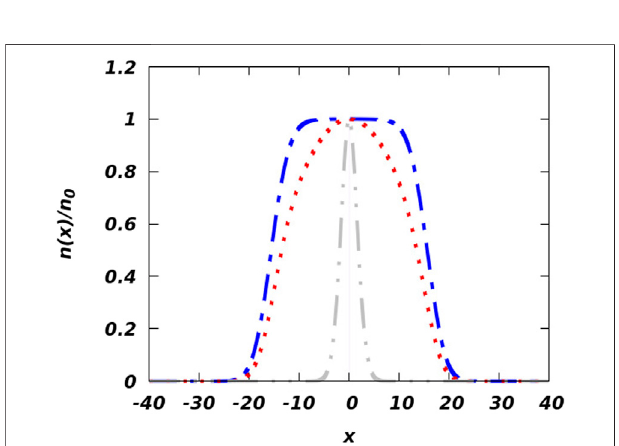
FIGURE8| (Coloronline)Thedensity pro fi leofthenumericalsolutionfor different K values is depicted here. The blue dashed-dotted line describes the density for K = 0.00001, the red dotted line describes K = 0.001, and the grey dashed-double-dotted line is prepared for K = 0.1. Here, κ = g ′ /| g | = 0.1 and g is set at 1. The density is normalized by n 0 where n 0 is n ( x )| x = 0.